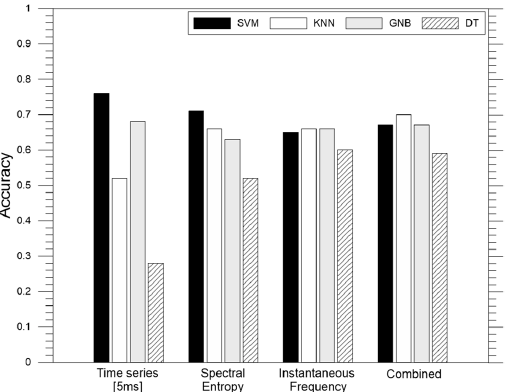
Figure 13. Comparison of accuracies using different input data from preprocessing. Note that the sampling rate used is 125 kHz and ‘Combined’ represents the combination of spectral entropy and instantaneous frequency.